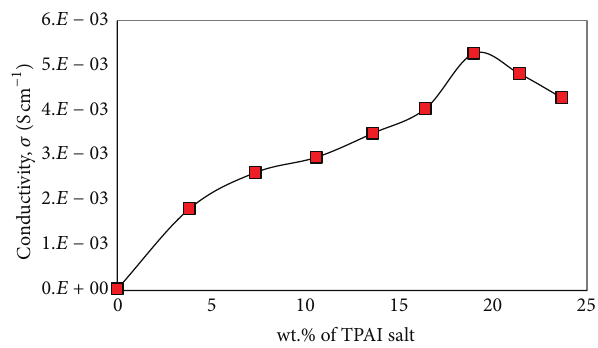
Figure 1: Effect of Pr 4 NI concentration on the conductivity at 25 ∘ C.